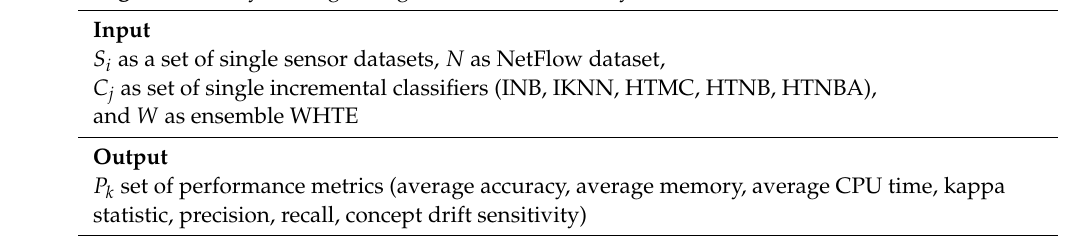
Algorithm 1. Hybrid Lightweight Attack Detection